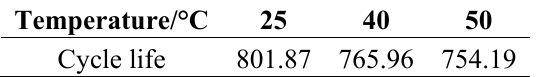
Table 2. Estimated cell cycle lifetime at the three